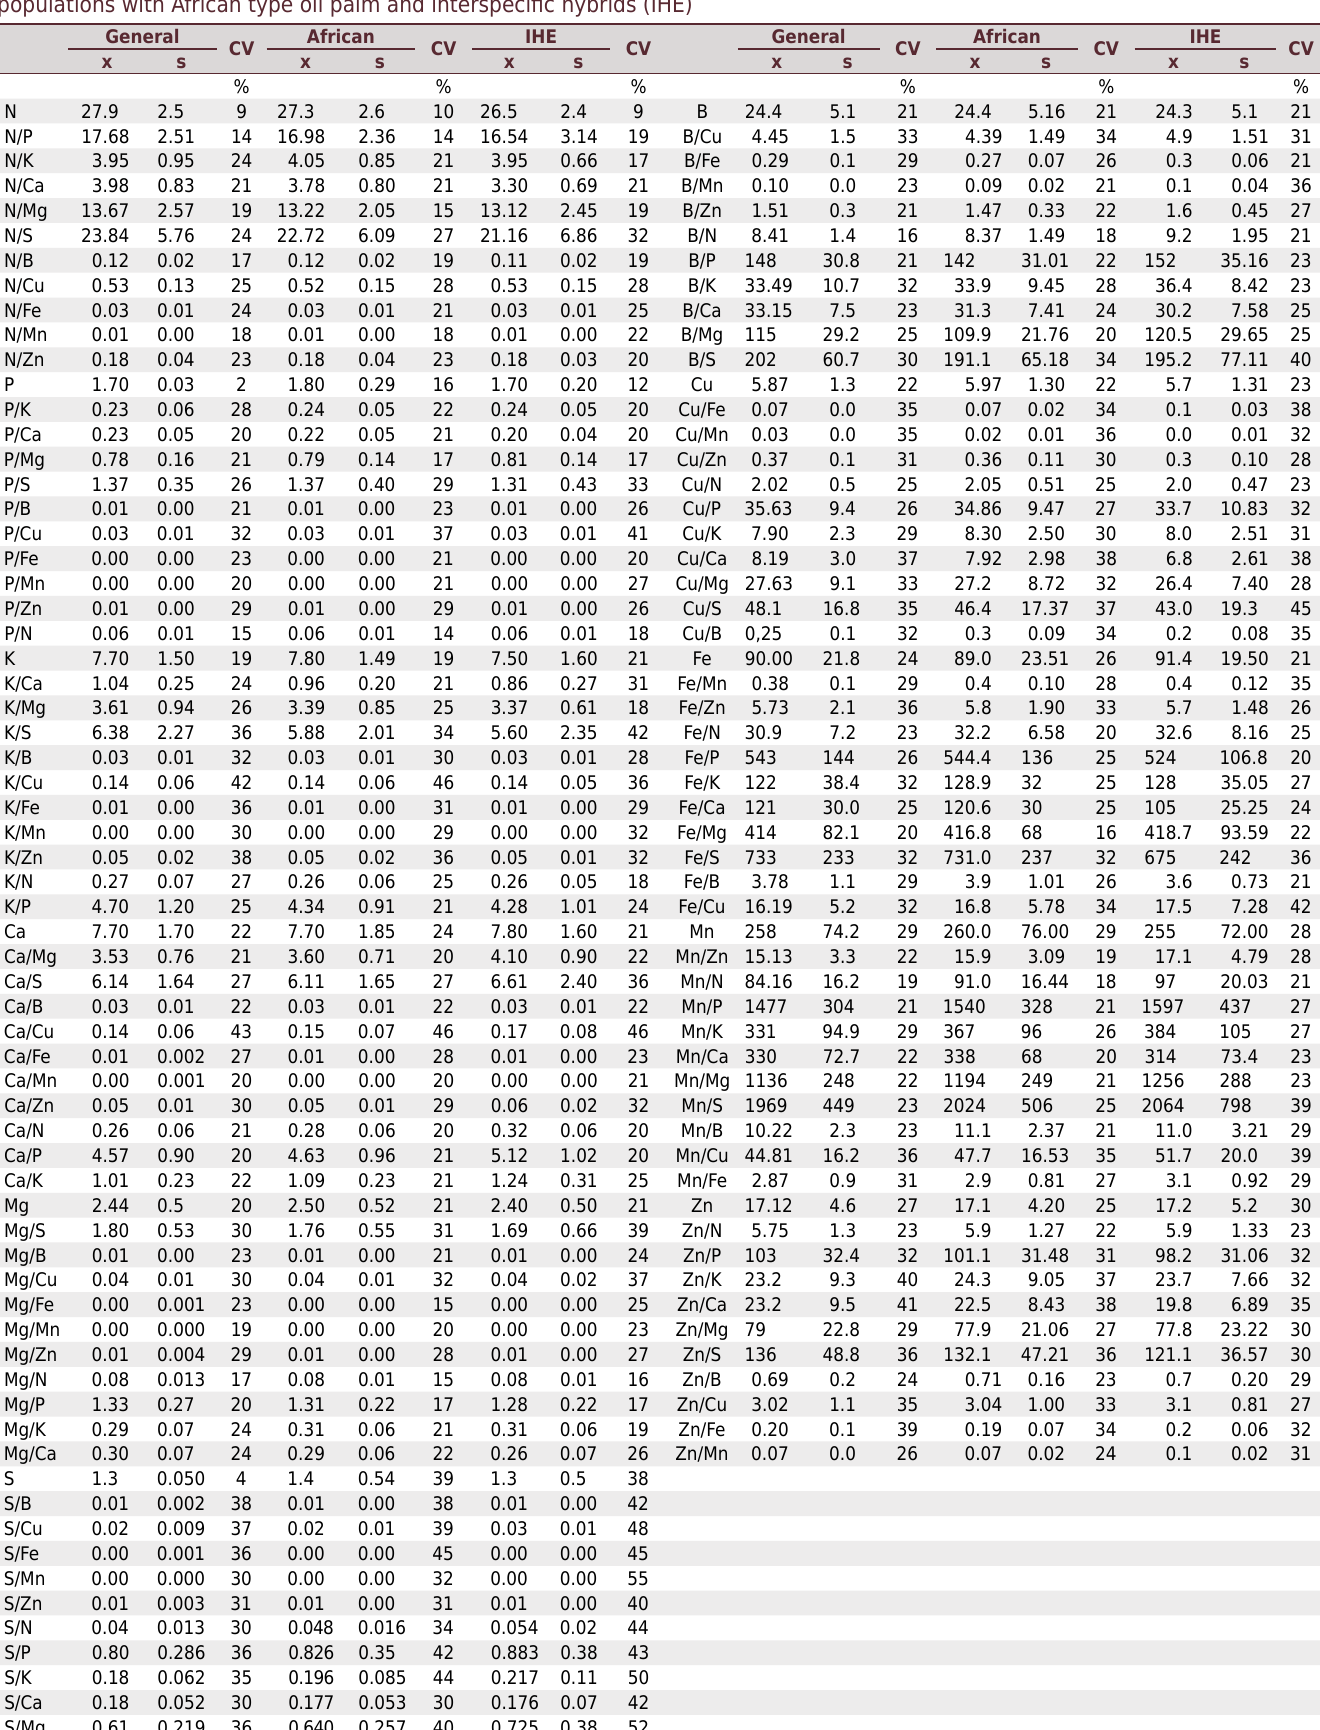
Table 2. Average (x), standard deviation (s), and coefficient of variation (CV) of the macro (g kg -1 ) and micronutrients (g kg -1 ) contents and nutritional relationships for a general control population (indiscriminately for genetic material and age) and for specific reference populations with African type oil palm and interspecific hybrids